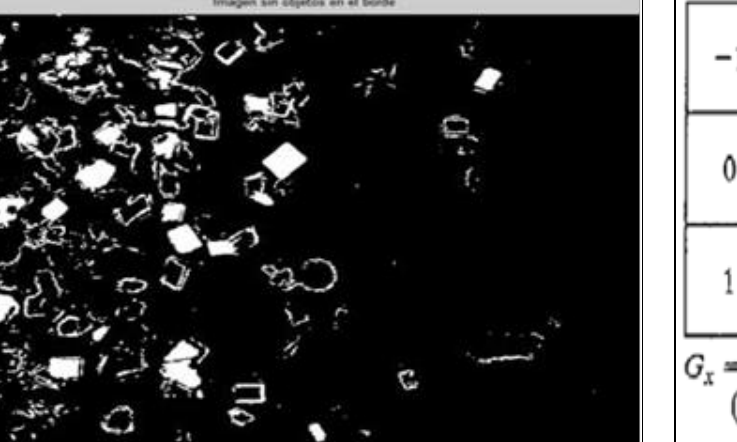
Figura 12: Imagen Sin Objetos en el borde. Fuente: Los autores, (2018).